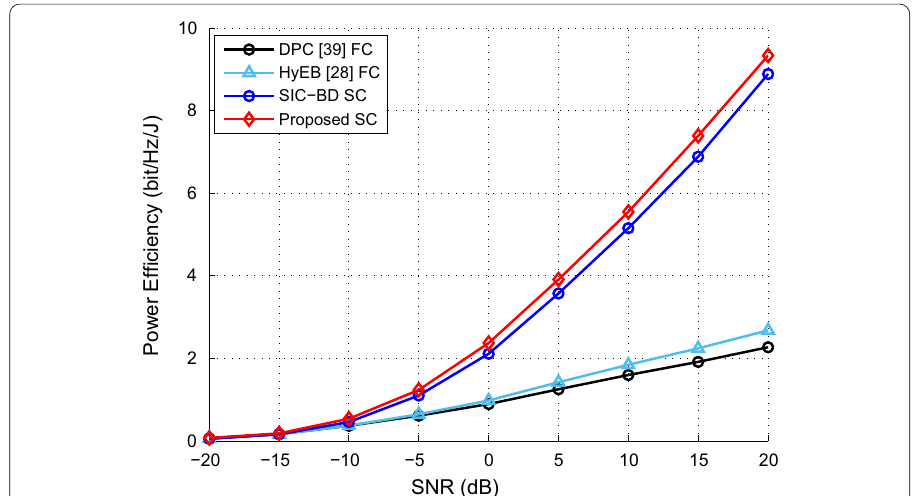
Fig. 8 Power efficient comparison for different hybrid precoding schemes versus SNR. The figure shows that the proposed method SC performs better than the method based on SIC-BD SC. The full-connected structure energy consumption is higher than